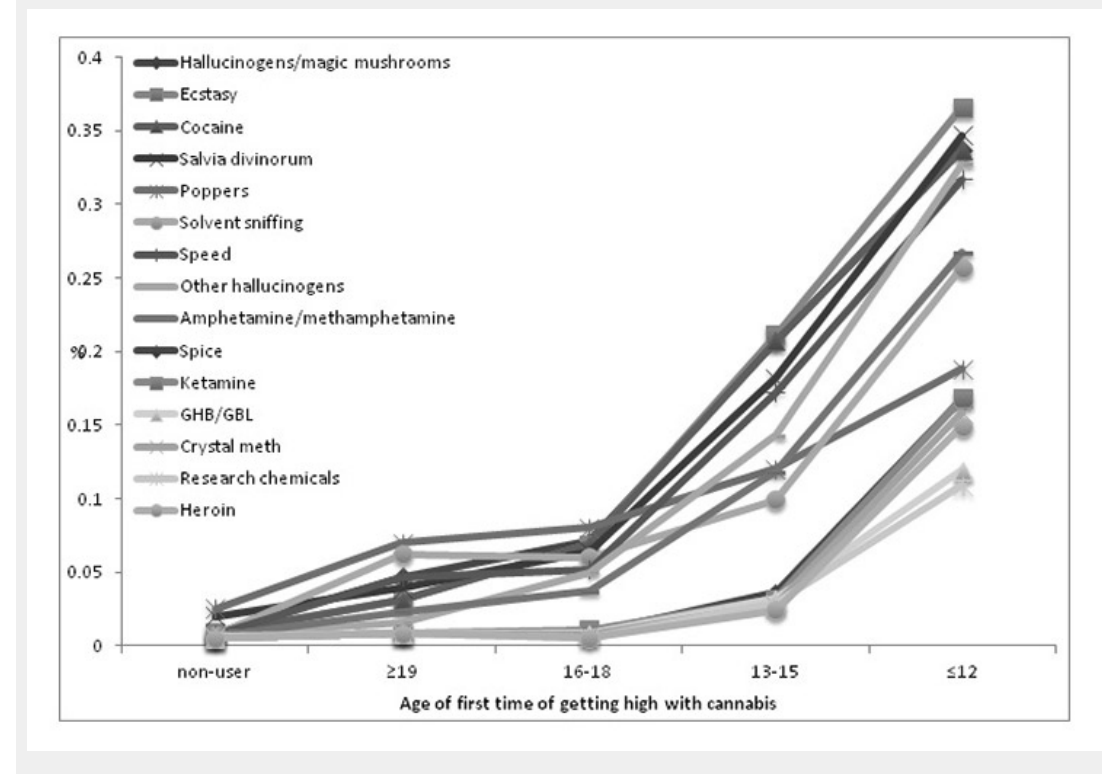
Figure 2 Prevalence rates of drug use according to age of first getting high with cannabis. The prevalence rate for each drug is given according to the age of first getting high with cannabis. For example, 14.9% of the participants who first got high with cannabis at age 12 years or earlier used heroin, whereas only 2.4% of the participants who first got high with cannabis at age 13 to 15 used heroin (percentages can be found in table